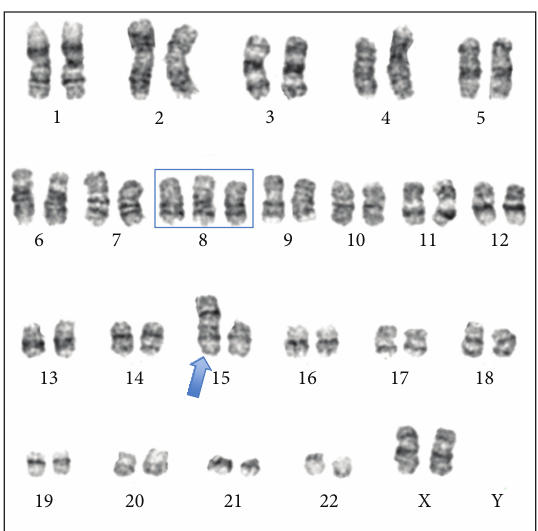
Figure 1: Conventional cytogenetic analysis of bone marrow aspirate sample showed the presence of 47,XX,+1,dic(1;15)(p11;p11),+8.